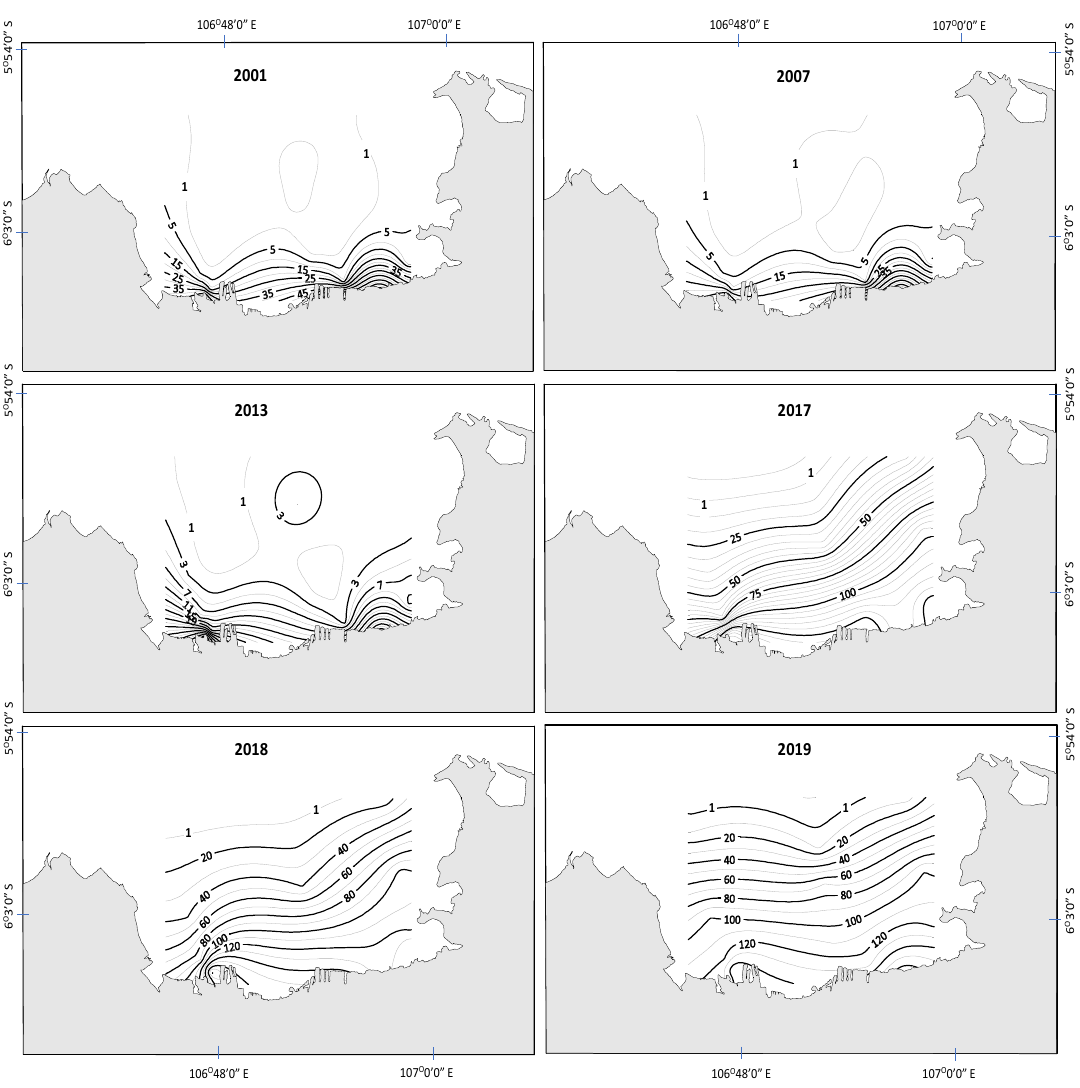
Figure 4. Spatial distribution of the mean dissolved inorganic nitrogen (DIN) concentration ( µ M) in Jakarta Bay.